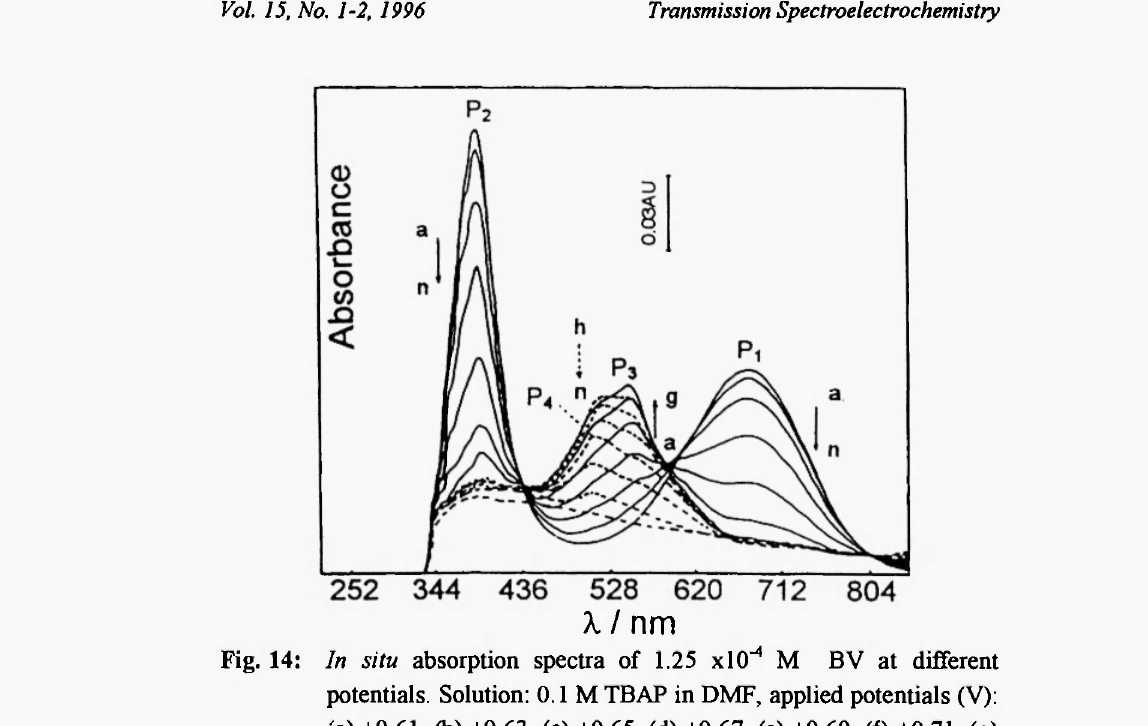
Fig. 14: In situ absorption spectra of 1.25 xlO" 4 Μ BV at different potentials. Solution: 0.1 Μ TB AP in DMF, applied potentials (V): (a) +0.61, (b) +0.63, (c) +0.65, (d) +0.67, (e) +0.69, (f) +0.71,